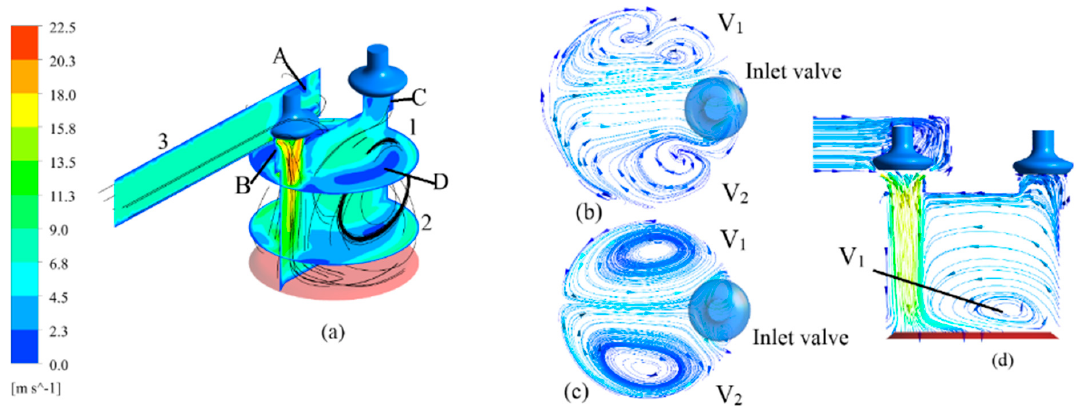
Figure 7. Vortex flow in cylinder during the intake process: ( a ) Main view; ( b ) View 1: cross ‐ section vertical to the inlet valve axis, 10 mm below the inlet valve; ( c ) View 2: cross ‐ section vertical to the inlet valve axis, 50 mm below the inlet valve; ( d ) View 3: longitudinal ‐ section along the valve axes.